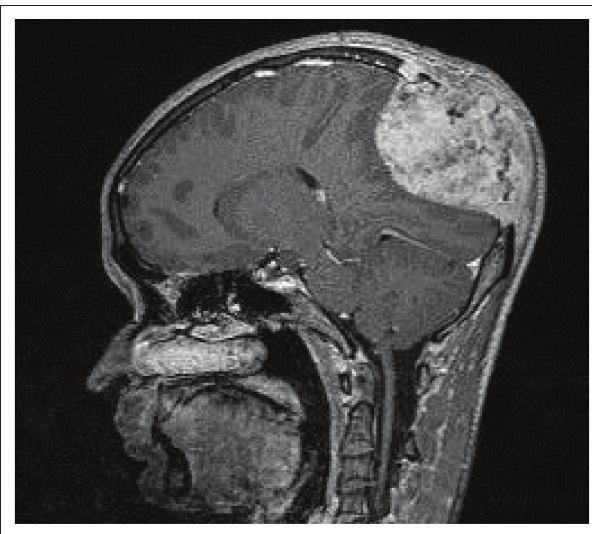
FIGURE 6: Contrast enhanced sagittal T1-weighted MR image also shows the mass lesion with lack of infiltration of adjacent brain